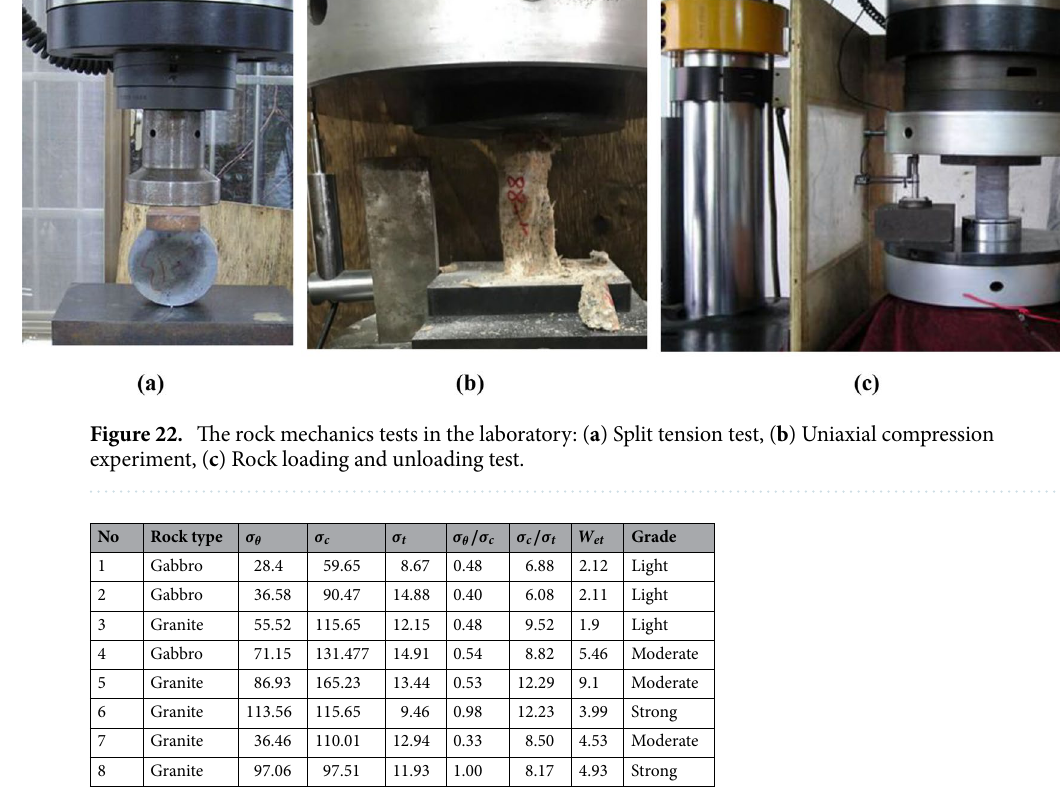
Table 16. Rock mechanics parameters and rockburst grade in Sanshandao Gold Mine.